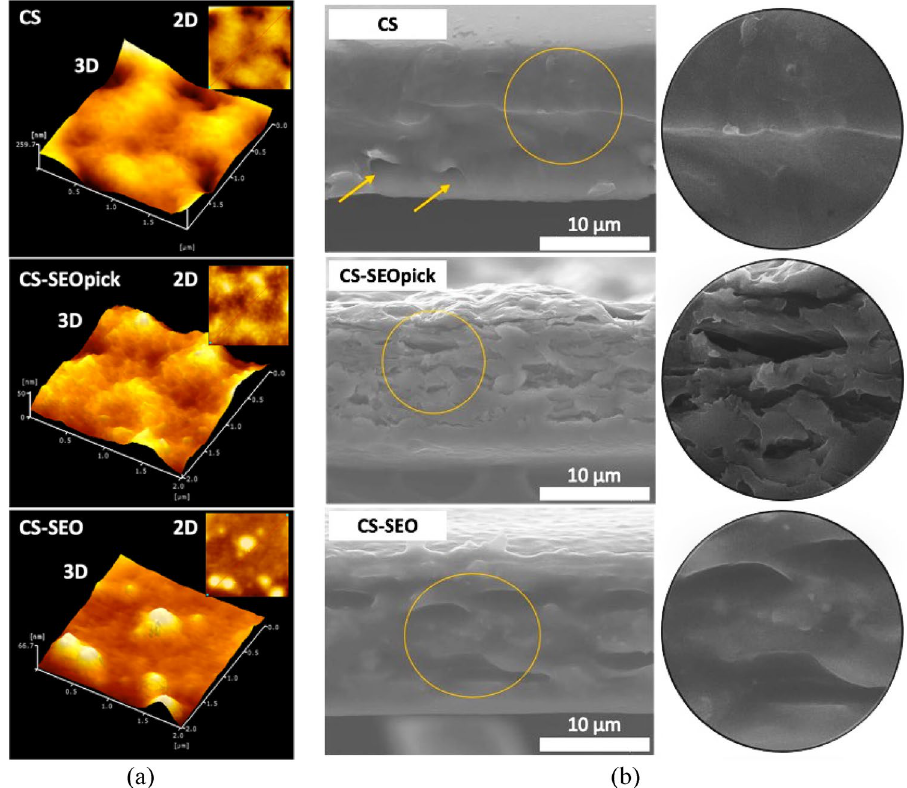
Figure 7. ( a ) AFM topographic image and ( b ) SEM longitudinal cross section image. CS chitosan, CS-SEOpick chitosan–sandalwood oil Pickering emulsion, CS-SEO chitosan–sandalwood oil regular emulsion